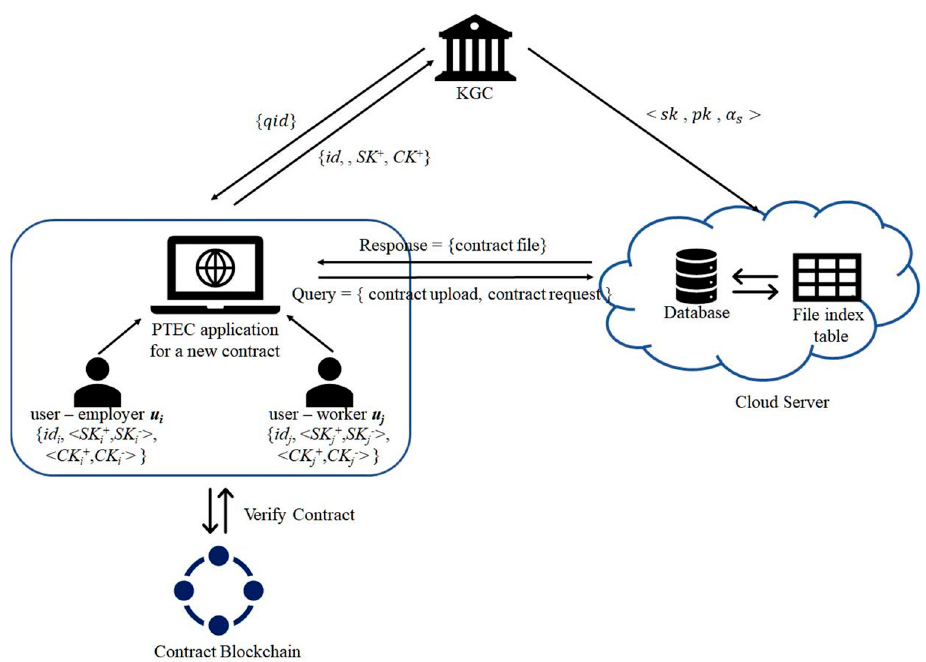
Figure 1. System configuration and operations.